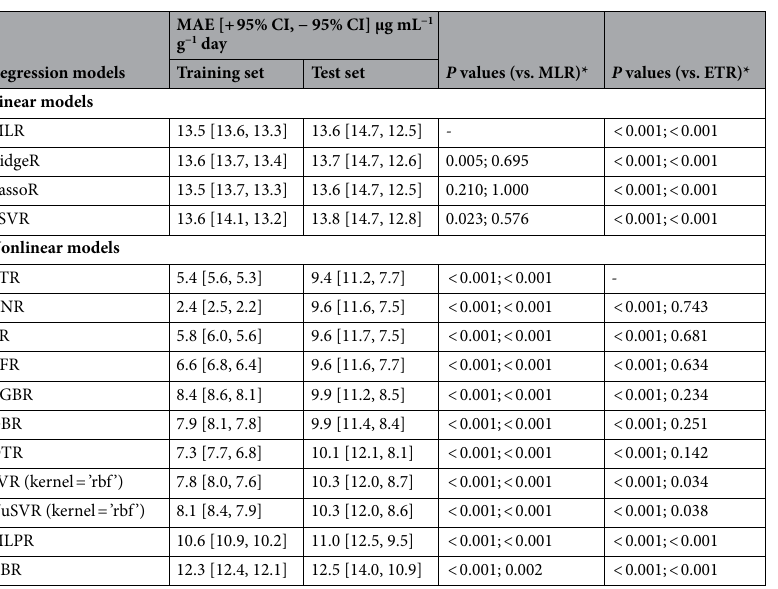
Table 4. The mean absolute error (MAE) at confidence intervals (CI) of 95% for the prediction of dose- adjusted concentrations of lamotrigine in the derivation cohort in the entire dataset for optimized regression models. MLR multiple linear regression, RidgeR ridge regression, LassoR lasso regression, LSVR linear-support vector regression, ETR extra-trees’ regression, KNR k-nearest neighbor regression, BR bagging regression, RFR random forest regression, XGBR XGBoost regression, GBR gradient boosted regression, DTR decision tree regression, SVR support vector regression, NuSVR nu-support vector regression, MLPR multi-layer perceptron regression, ABR AdaBoost regression. * P values for the training set (the left side of the semicolon) and the test set (the right side of the semicolon),